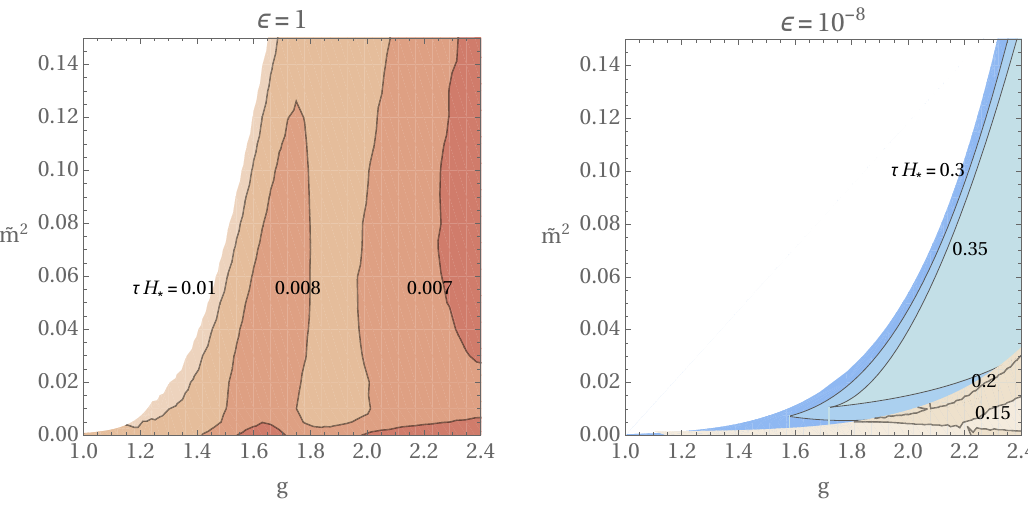
Figure 6 . Contours of the duration of the phase transition τ relative to the Hubble parameter when it occurs, for a hidden sector at the same temperature as the visible sector (left) in which case the transition happens via thermal fluctuations (red shading), and for a cold hidden sector 8 (right), in which case the bubbles are nucleated through tunnelling over most of the with (cid:30) = 10 − parameter space (blue